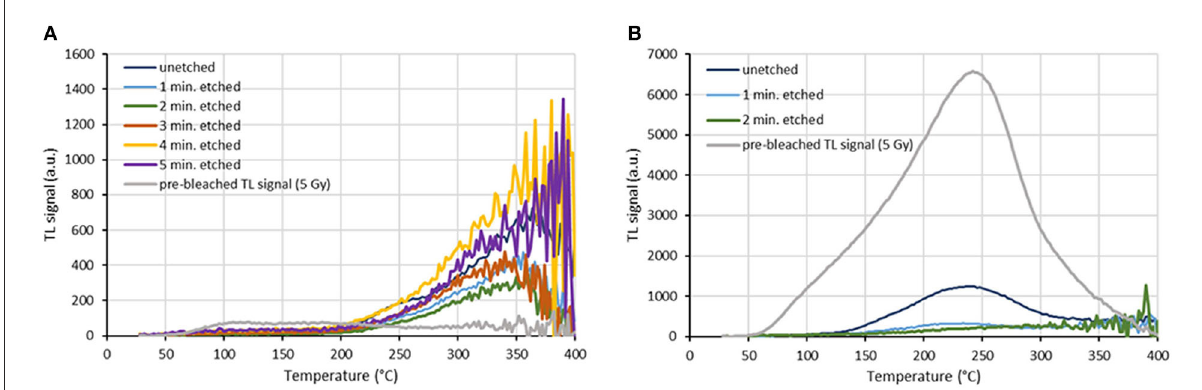
FIGURE3 Variation of etching time for two screen protectors. The intrinsic background signals are shown for an aliquot per etching time. The intrinsic background signal of an unetched aliquot and the radiation-induced TL signal of this aliquot are also shown. TL signals are normalized to aliquot mass. Screen protector ID: (A) P21, (B)